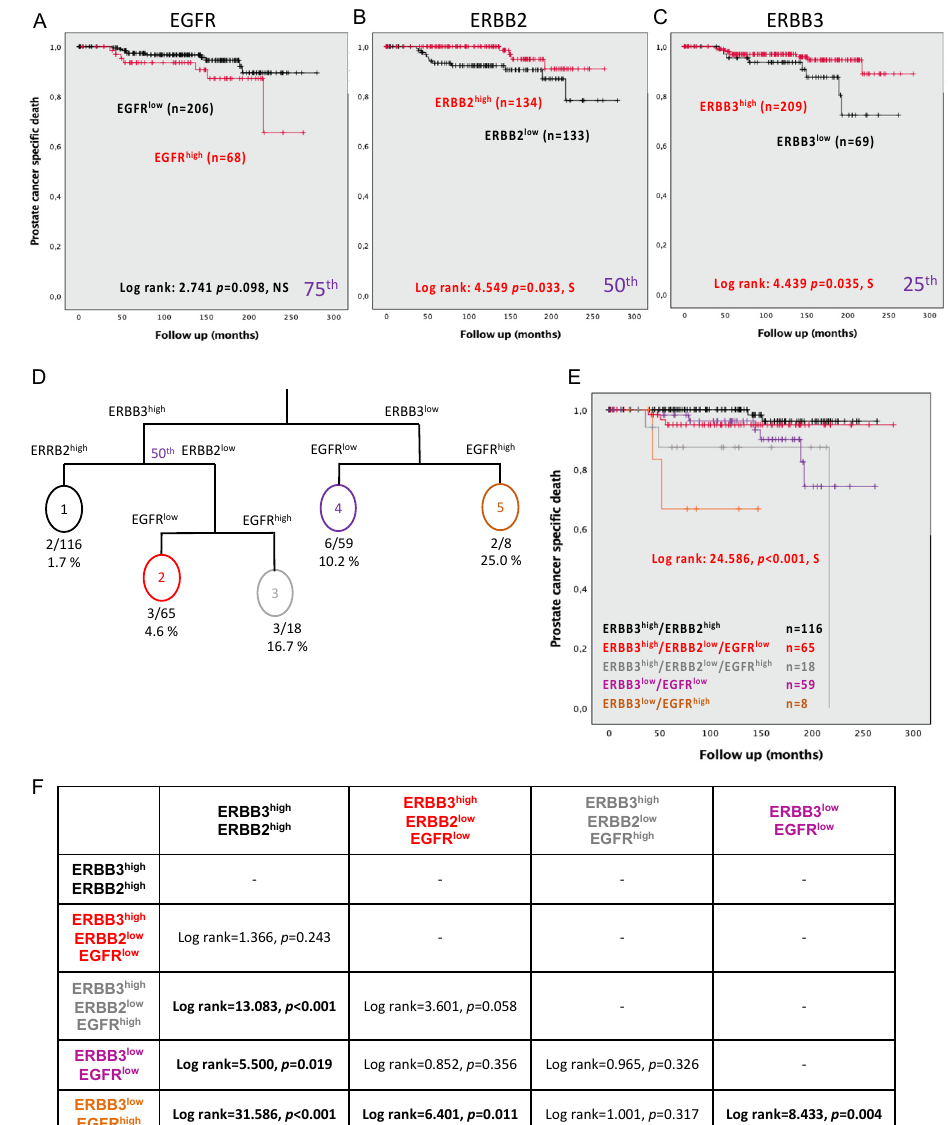
Figure 4. Association of the protein expression in the epithelial cells of tumor cores with prostate cancer-specific death. Kaplan–Meier curves for ( A ) EGFR with a cutoff at the 75th percentile, ( B ) ERBB2 with a cutoff using the median, and ( C ) ERBB3 with a cutoff at the 25th percentile. ( D ) Survival tree, including EGFR, ERBB2, ERBB3, and death by PC in an RPART model. ( E ) Kaplan–Meier plot combines EGFR, ERBB2, and ERBB3 expression. ( F ) Summary table of log rank between each of the conditions of expression of ERBB members. Significance is indicated by log-rank test. p < 0.05 was considered significant; NS, not significant; S, significant.